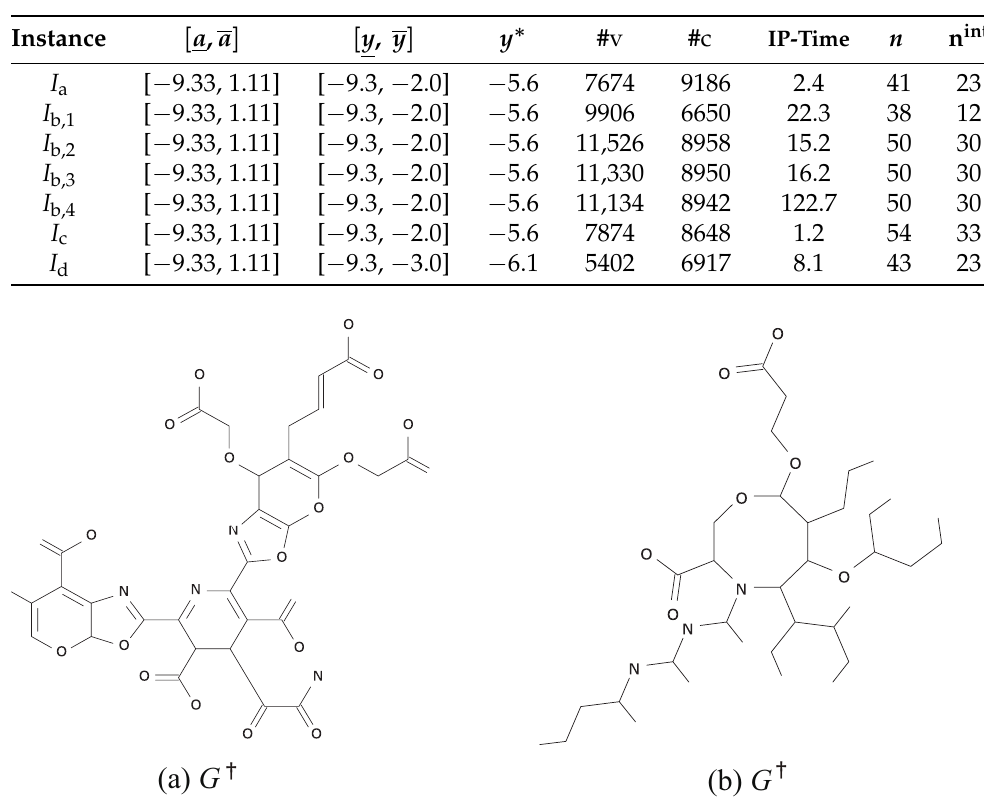
Table 12. Results of Stage 4 for S L .